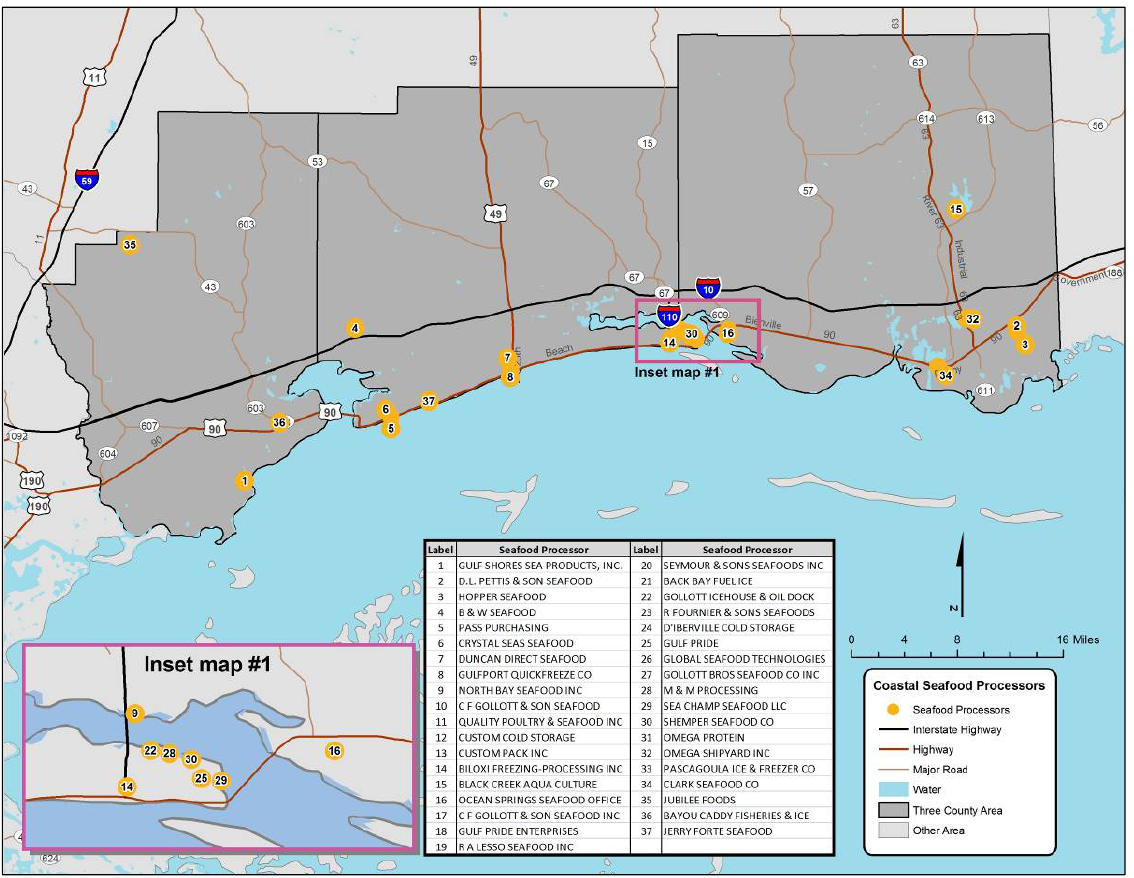
Figure 2. Seafood Processors on the Mississippi Gulf